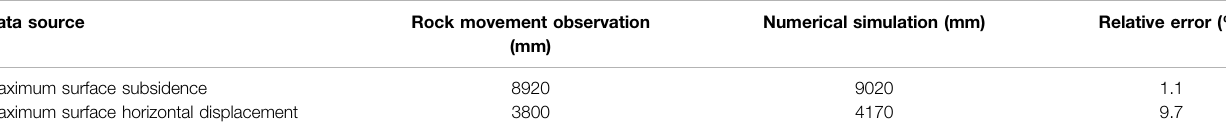
TABLE 5 | Comparison of numerical simulation results and rock movement